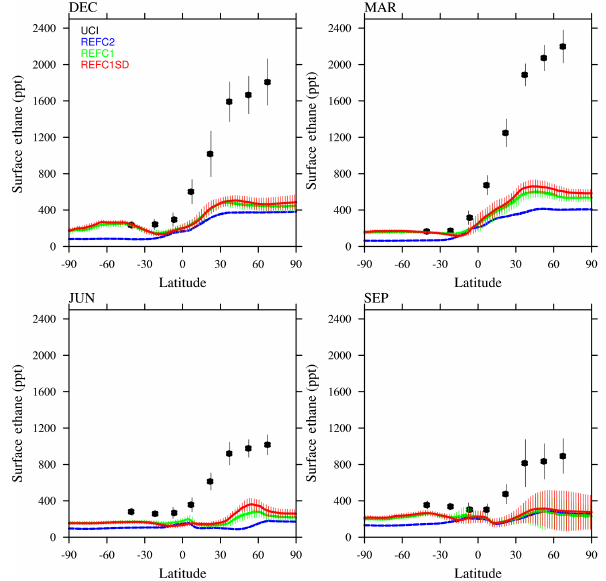
Figure 10. Comparison of observed and modeled surface ethane (C 2 H 6 ) mixing ratios in each season averaged over 1995–2010 along the length of the Pacific Ocean. Monthly mean CAM4-chem ethane mixing ratios at 190 ◦ E are shown for the three model exper-